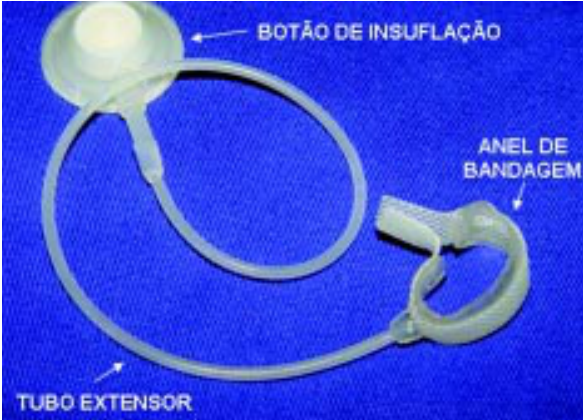
Fig. 1 - Dispositivo de bandagem ajustável do TP utilizado no protocolo, produzido pela SILIMED (Rio de